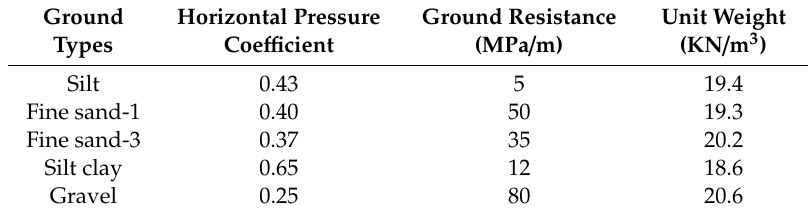
Figure 11. Numerical modeling for the study site: ( a ) geological conditions; and ( b ) numerical model. Table 3. Mechanical parameters of surrounding rocks in the site.